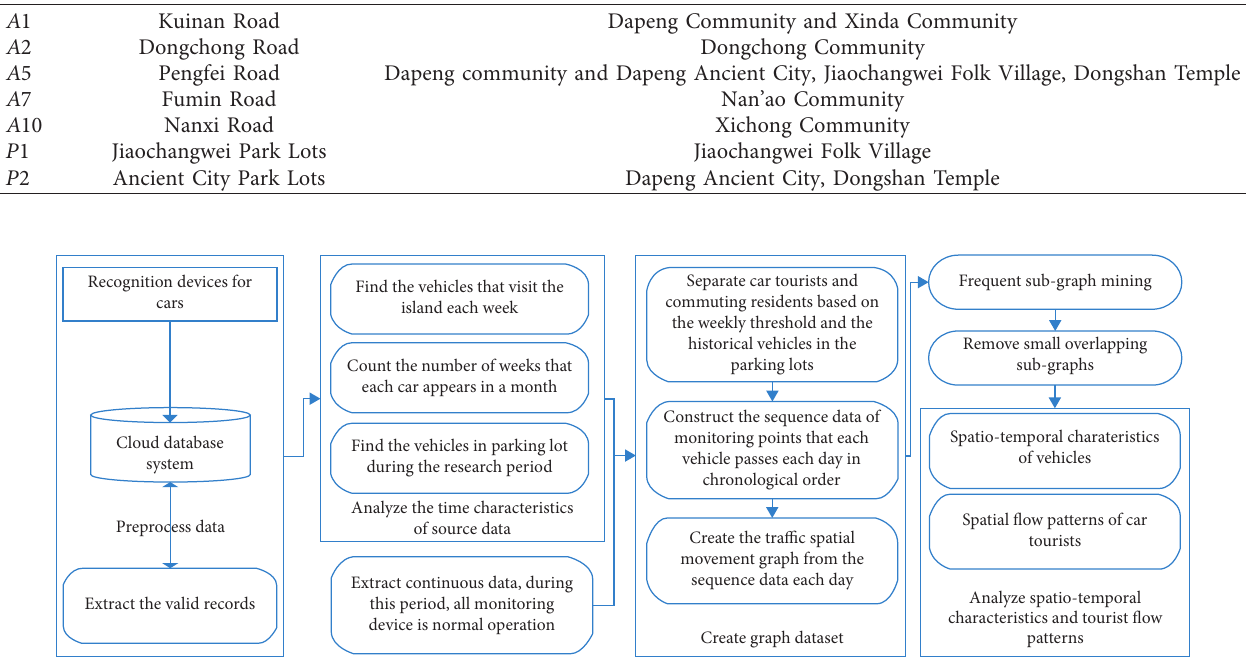
Figure 3: The detailed steps for mining frequent patterns in tourist